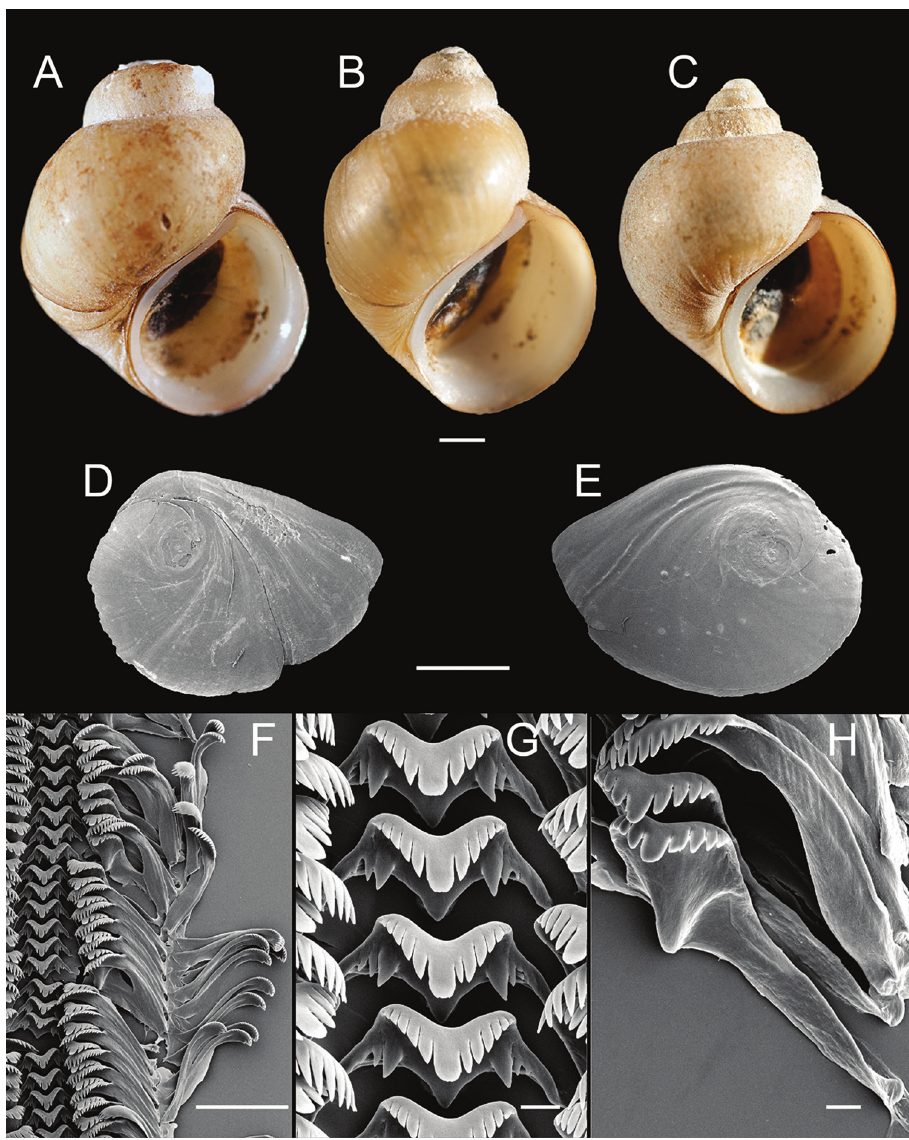
Figure 6. Shells, opercula and radula, F. umpquaensis , sp. n. A Holotype, USNM 1144535 B Shell, USNM 1144736 C Shell, USNM 1144371 D, E Opercula (outer, inner sides), USNM 114535 F Por- tion of radular ribbon, USNM 1422224 G Central teeth, USNM 1422224 H Lateral teeth, USNM 1422224. Scale bars: A–E , 1.0 mm; F , 100 µm; G–H , 10 µm. 1144736, east side of Umpqua River at Cleveland Rapids, Cleveland Rapids Park, opposite and northeast of Cleveland (43.2972°N, 123.4686°W), USNM 1144748, Myrtle Creek just upstream of OR99 (Myrtle Creek Highway) bridge